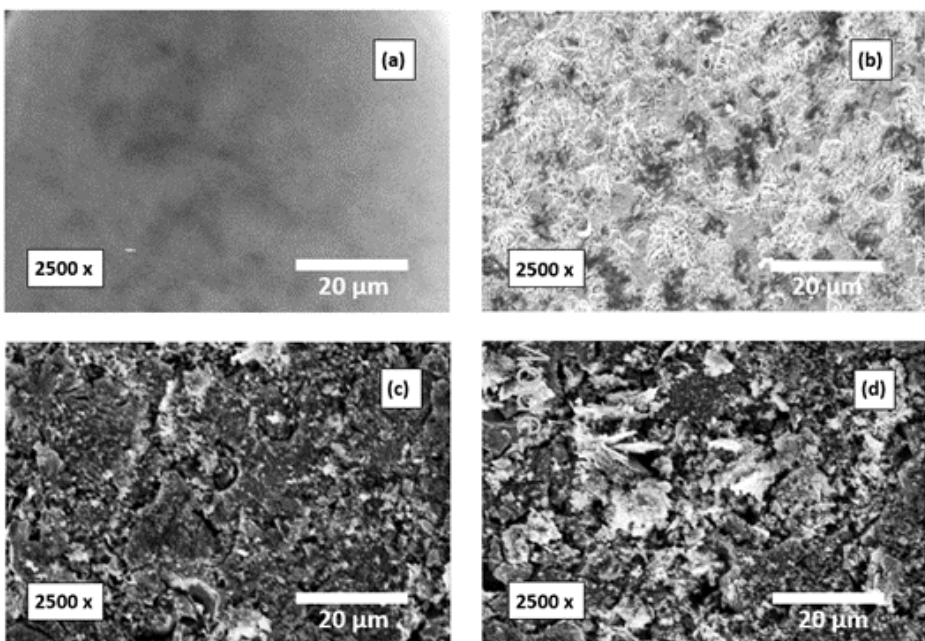
Figure 15. SEM images (Mag. 2500×) of the surfaces of Al specimens; ( a ) prior to dipping, ( b ) after dipping in 0.1 M NaOH medium for 12 h, ( c , d ) after 12 h of dipping in 0.1 M NaOH with a 500 mg/L of amygdalin and raffinose, correspondingly.